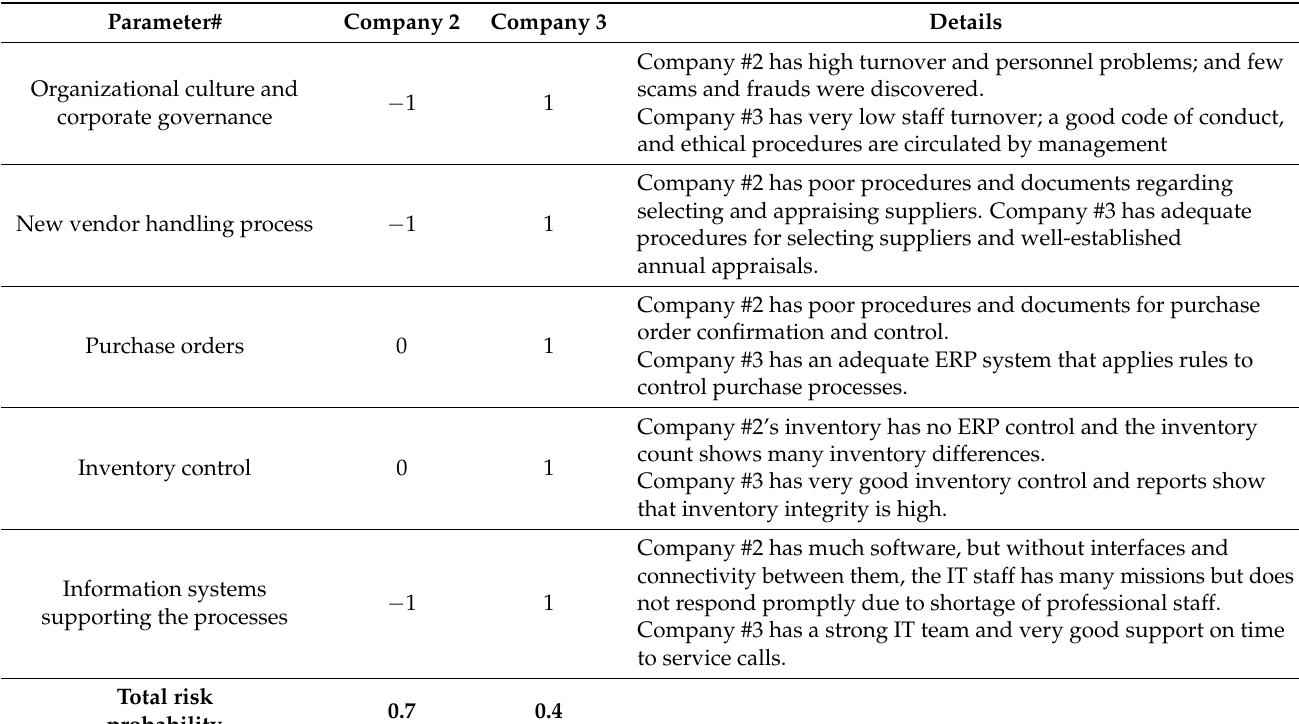
Table 2. Example of two companies from the